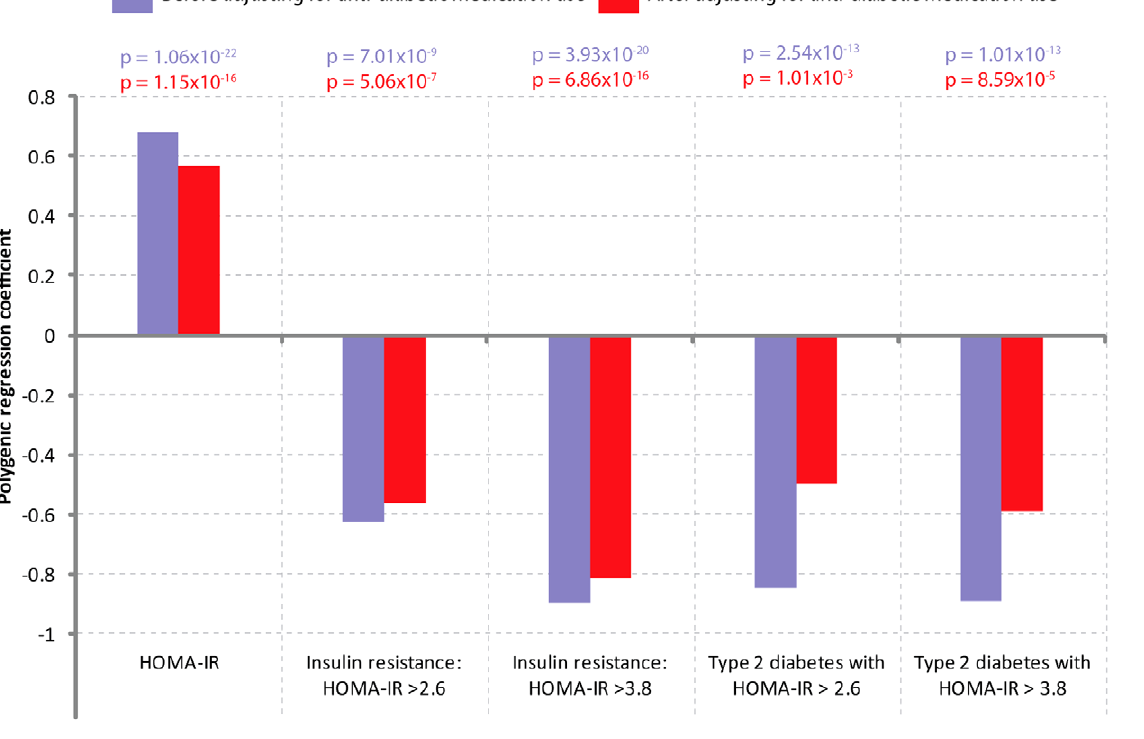
Figure 3. Association of dichotomized WC with IR and insulin resistant T2D. The bars represent regression coefficients estimated using polygenic regression models. Results are shown before (purple bars) and after (red bars) adjusting for the use of antidiabetic medication which includes the oral antidiabetic drugs as well as insulin. Statistical significance of a regression coefficient is shown in color-coded fashion at the top of the graph.